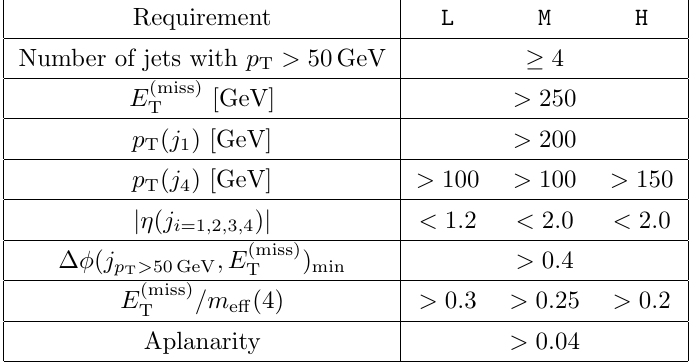
Table 5. De(cid:12)nition of preselection-L, M, H . Besides these criteria, we require that neither electrons nor muons be reconstructed.